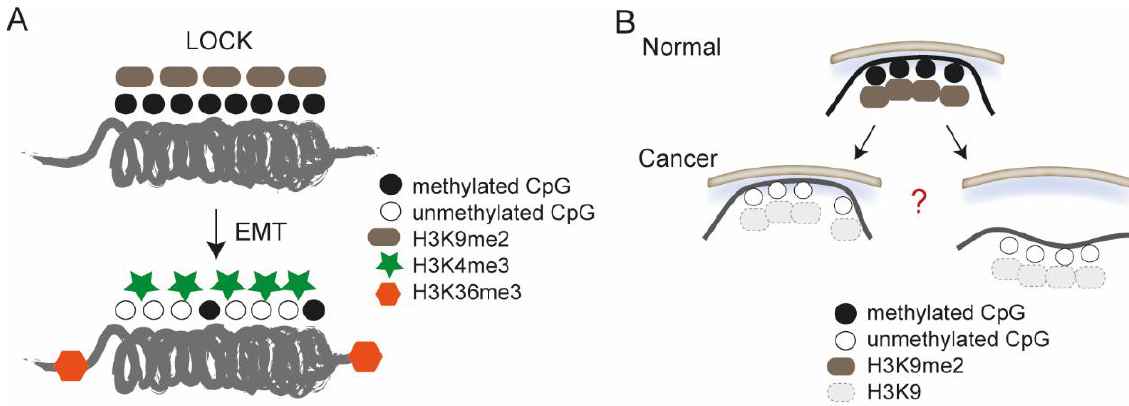
Figure 2. Epigenetic reprogramming of large organized chromatin K9 modifications (LOCKs)/LADs in cancer cells. ( A ) Epigenetic alterations targeted to LOCKs upon TGFβ -induced epithelial-to-mesenchymal transition (EMT). ( B ) LOCKs/LADs, naturally enriched in H3K9me2 and DNA methylated (top), lose their heterochromatic states in cancer (bottom). What is still unclear is whether cancer cell LADs are actually H3K9me2 poor and DNA hypomethylated, and whether LOCKs/LADs losing H3K9me2 detach from the nuclear lamina (bottom right) or are retained at the lamina as euchromatic LADs (bottom left).